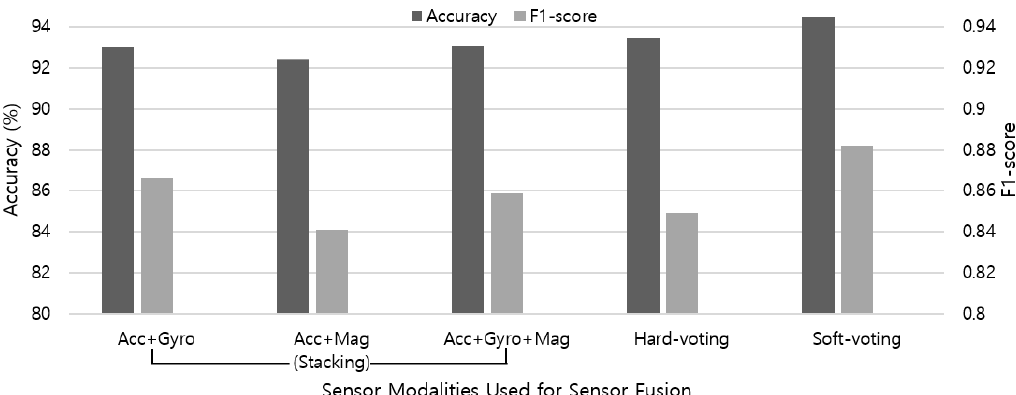
Figure 14. Recognition accuracy and F1-score measure of stacking ensemble using various combinations of sensors, and two voting ensemble techniques adopting all sensor